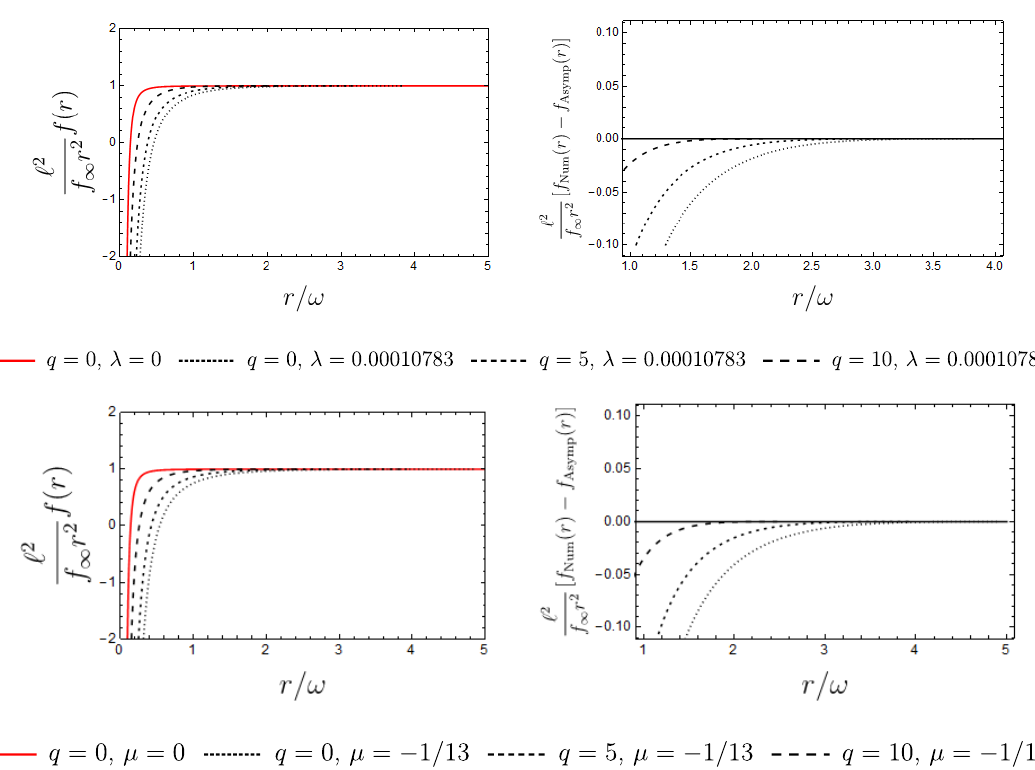
Figure 1 . Numerical solutions . Top row : four dimensional numerical solutions to the cubic theory. The left panel shows a plot of the rescaled metric function for three di(cid:11)erent electric charges at non-zero cubic coupling. The right panel shows the di(cid:11)erence between the rescaled metric function and the asymptotic solution as r increases. Bottom row : four dimensional numerical solutions to the quartic theory. The left panel shows a plot of the rescaled metric function for three di(cid:11)erent electric charges at non-zero cubic coupling. The right panel shows the di(cid:11)erence between the rescaled metric function and the asymptotic solution as r increases. In all cases, we have set ‘ = 1. In each of the left panels, the solid, red line corresponds to the Einstein-AdS black brane with the choice ! = 18 :